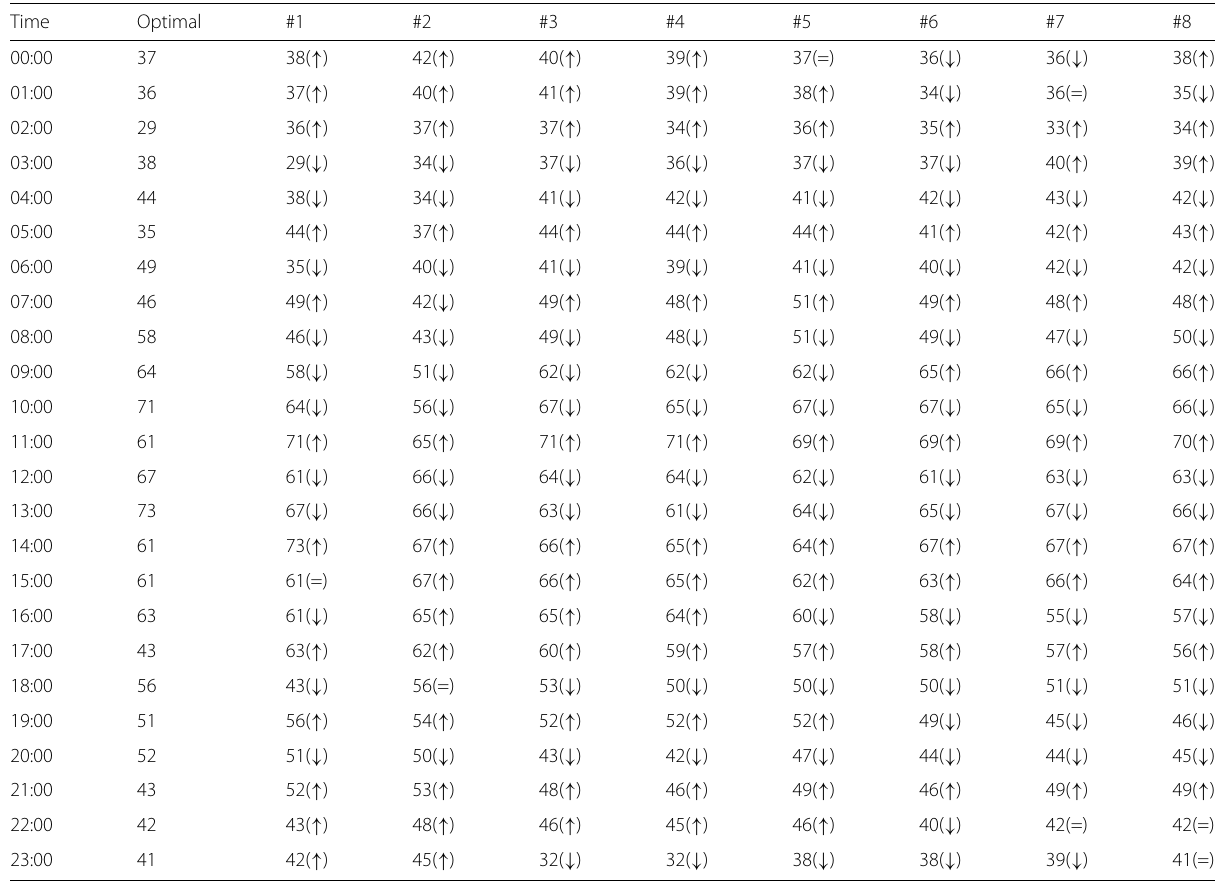
Table 4 Allocation 1: Optimal resource allocation (based on real load) vs. estimated resource allocation (based on predicted loads, forecasting models #1 to